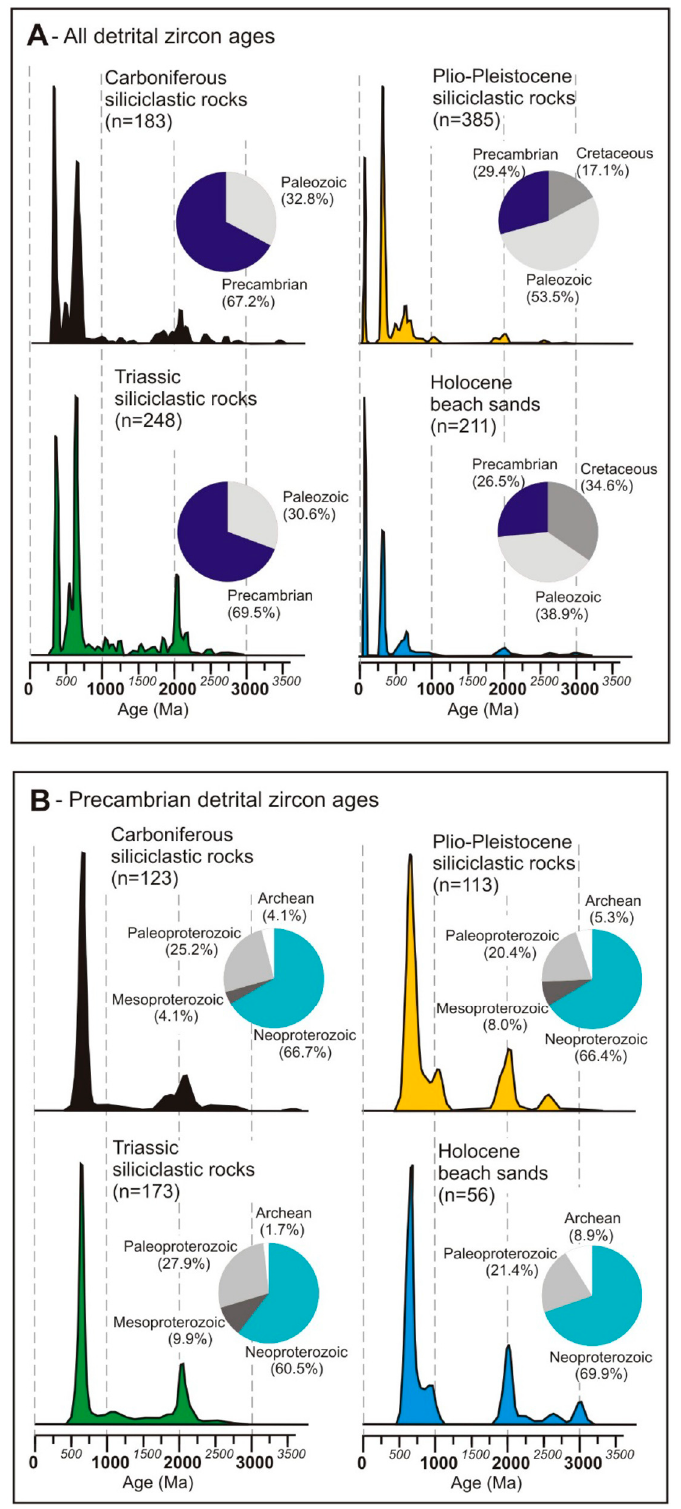
Figure 3. Kernel density estimation (KDE) plots and pie charts with U–Pb detrital zircon ages of the Carboniferous (Mira Formation, South Portuguese Zone), Triassic (Silves Group, Alentejo Basin), Pliocene-Pleistocene (Alvalade Basin) siliciclastic rocks, and Holocene beach sands from the Sines region. ( A ) All detrital zircon ages. ( B ) Precambrian detrital zircon ages (U–Pb data compiled from